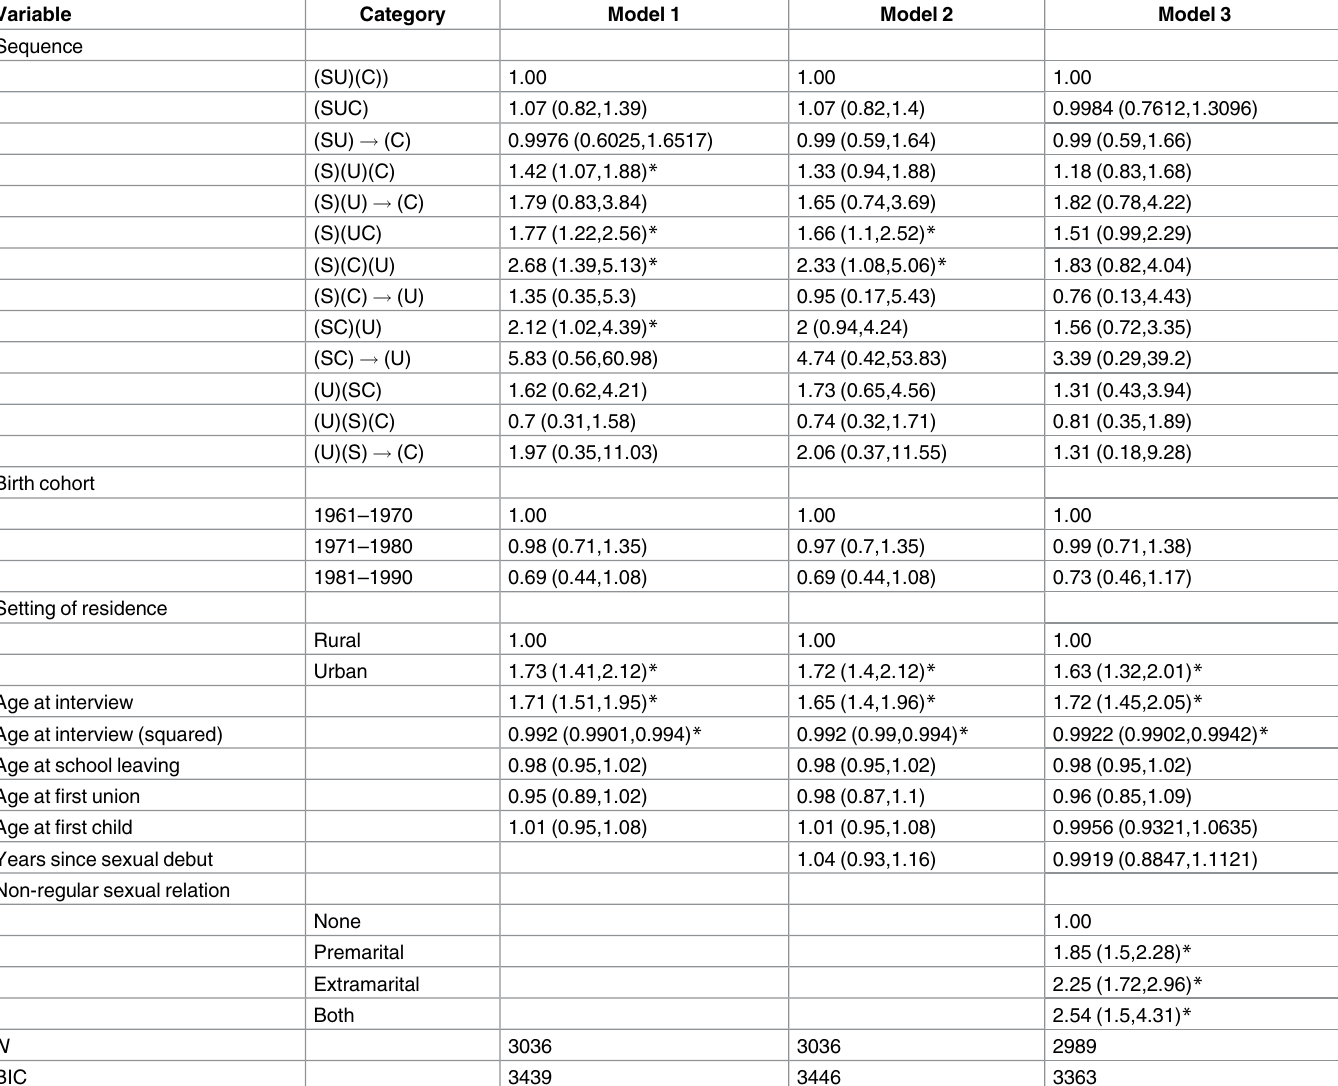
Table 3. Adjusted prevalence odds ratios for women. Adjusted odds ratios and 95% confidence intervals for the probability of being HIV-infected, based on logistic regressionmodels, among women, Manicaland (Zimbabwe), 2000–2011. Sample size is varying because of missing